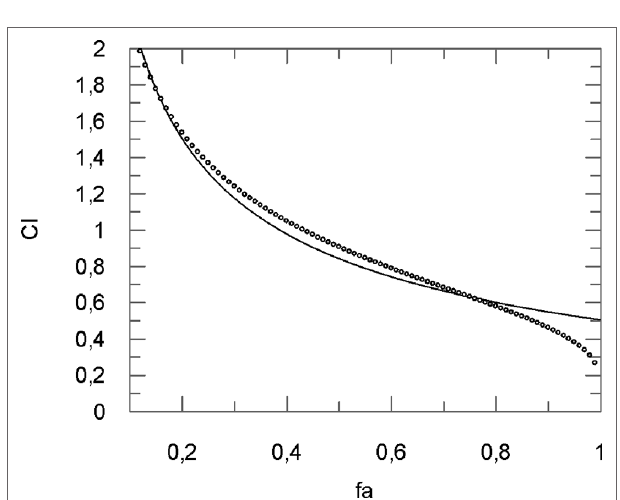
FIgURE 6 | Computer-generated graphical presentation of the combination index (CI) vs the fraction affected, i.e. the effect of reduction of IL-1β mRNA levels exerted by a mixture of curcumin-BCP (molar ratio, 1:3.6) in chondrocytes.